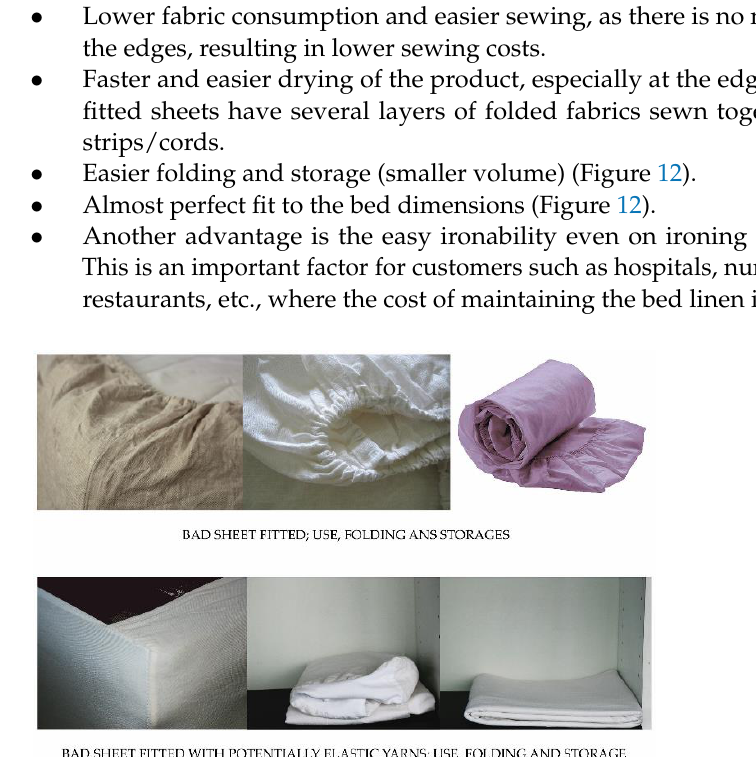
Table A1. Properties of terry samples before (b.t.) and after (a.t.) treatment. Designation